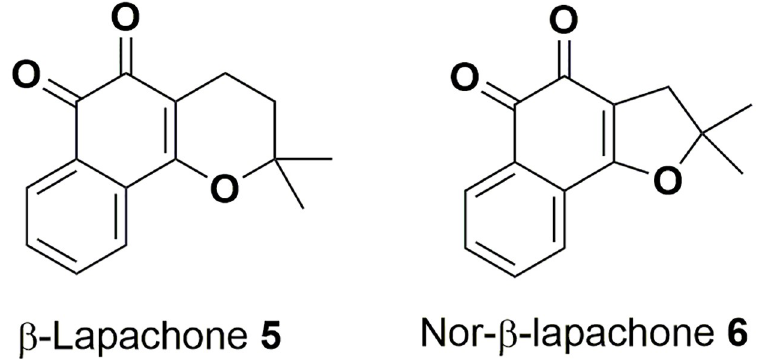
Fig 2. Structures of β -lapachone 5 and nor- β -lapachone